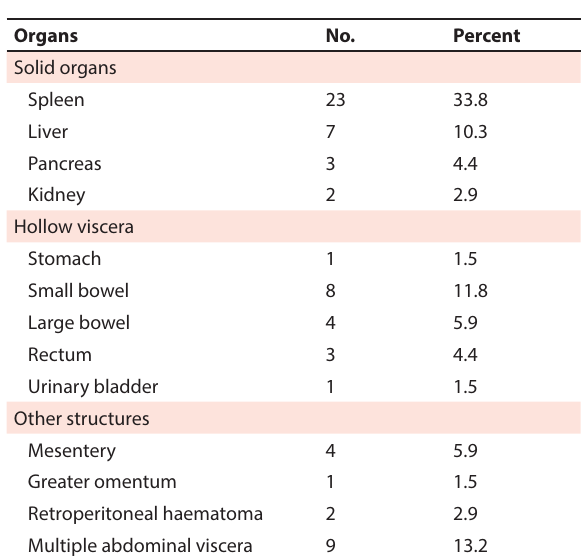
Table 2. Intraabdominal visceral injuries